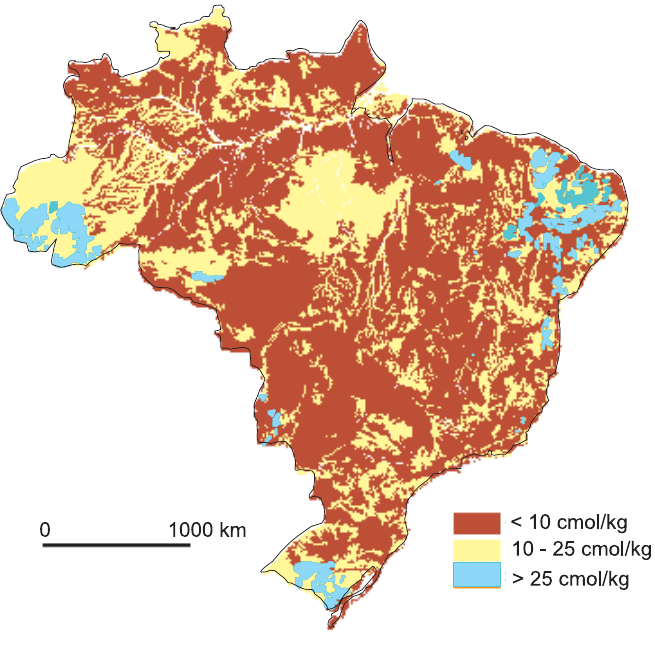
Fig. 2 – Distribution of cation exchange capacity (CEC in cmol c /kg) values in Brazil.